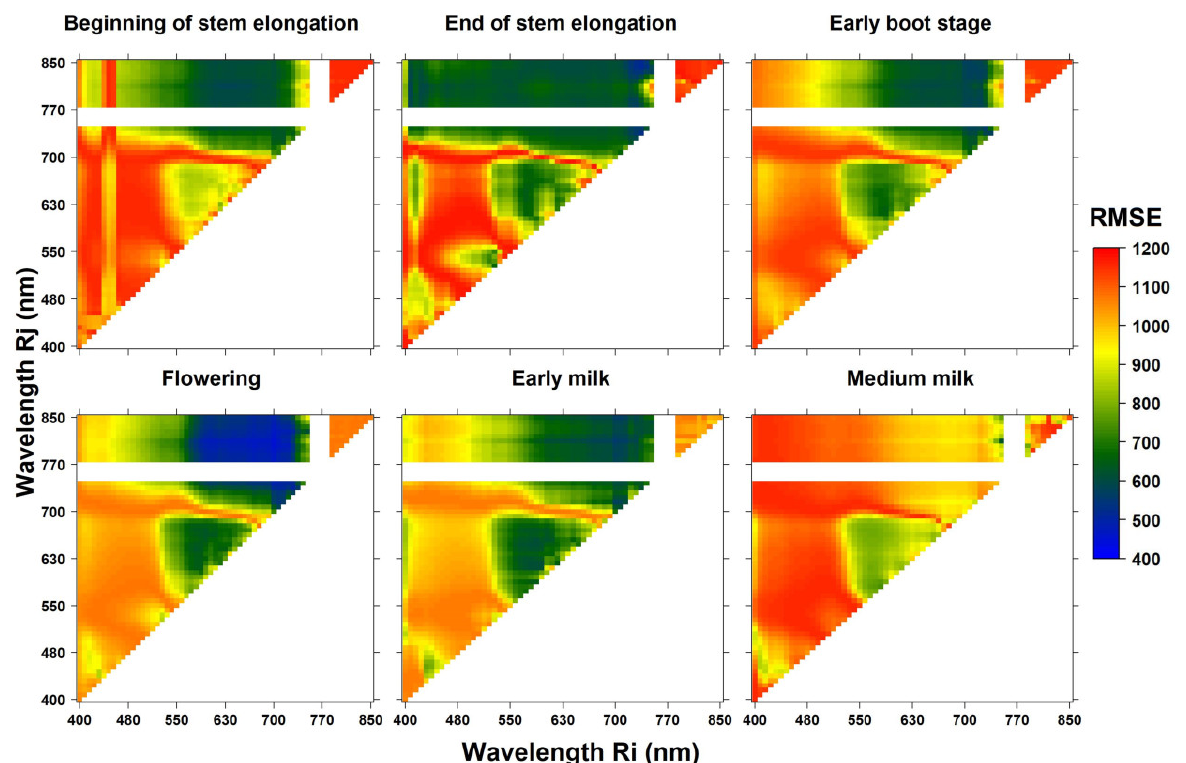
Figure 6. Contour maps of the root mean square error (RMSE, kg ha − 1 ) between the normalized difference spectral index (NDSI) ( Ri , Rj ) and grain yield using the complete combinations of two wavelengths at i and j within the range 400–850 nm. At each growth stage, data from the different years were merged to build the